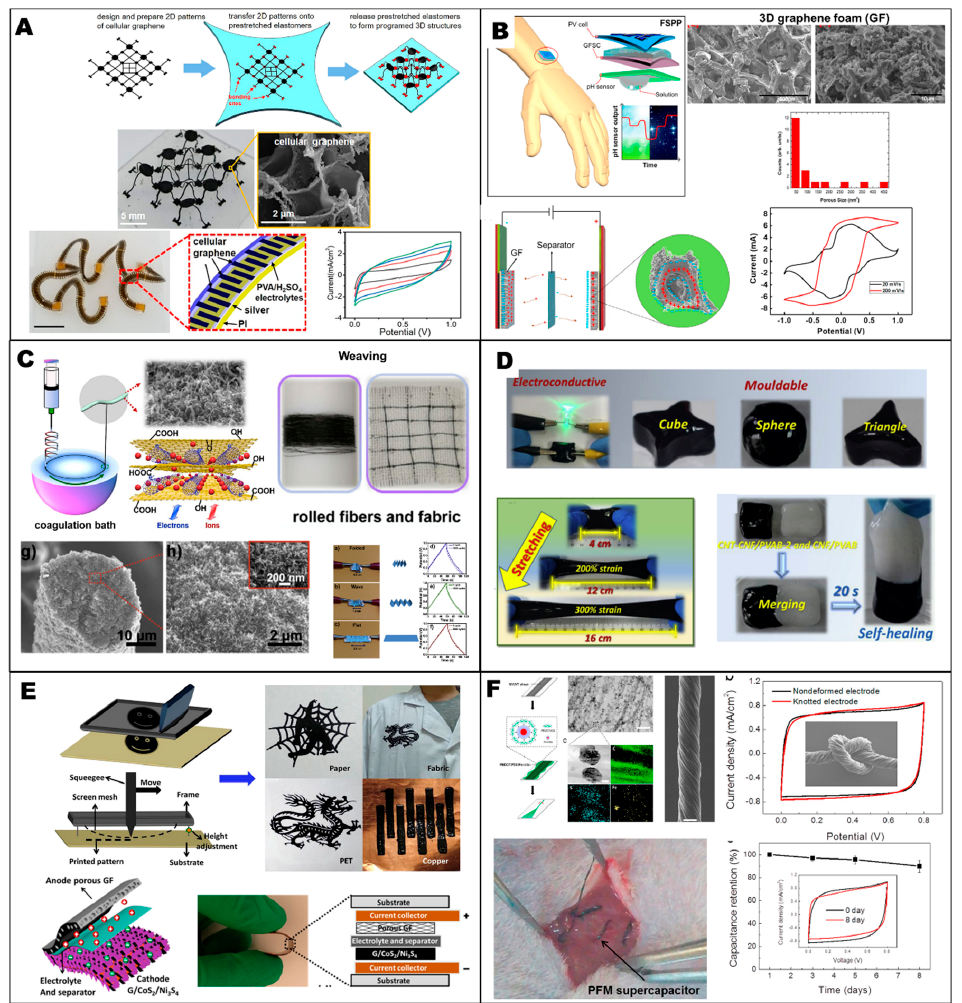
Figure 3. Examples of applications of carbon materials for supercapacitors and potential